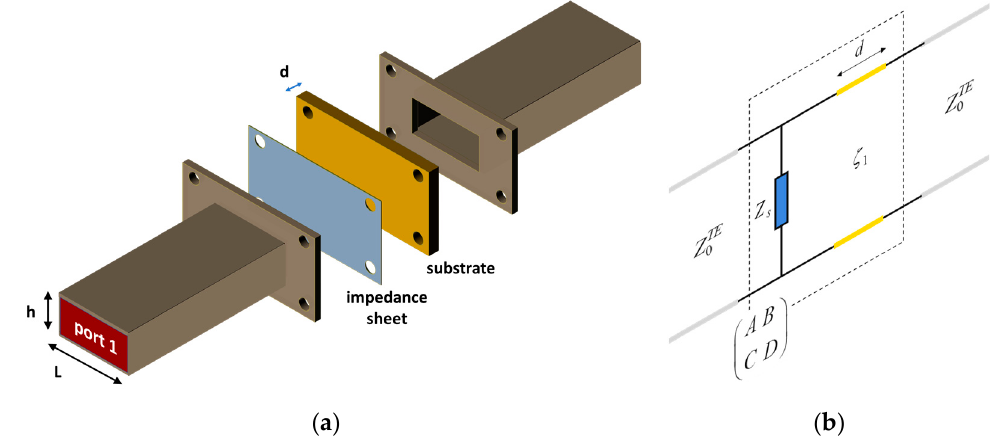
Figure 17. ( a ) Measurement setup and ( b ) simplified transmission line model.